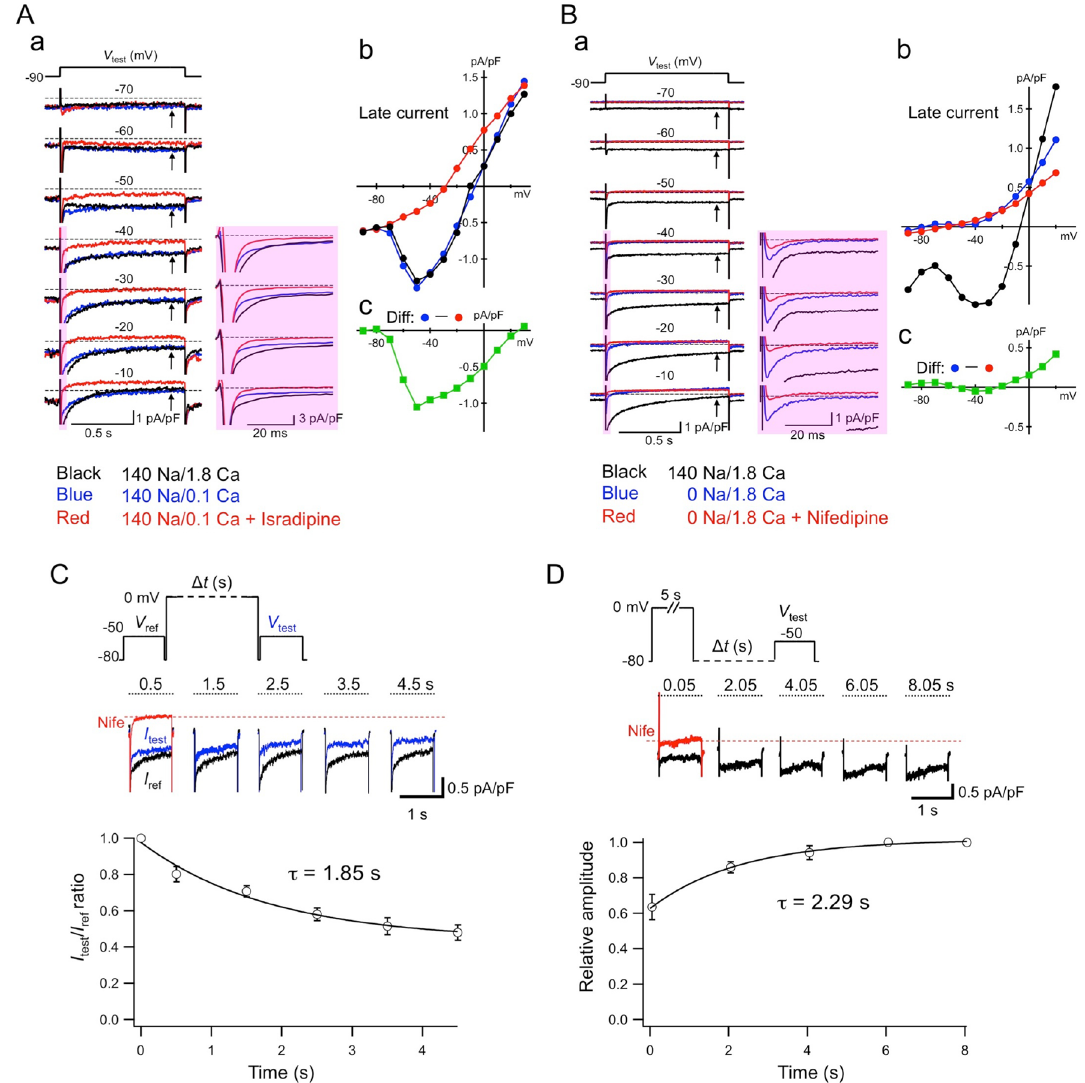
Figure 1. Presence of I st in mouse SAN cells. ( A ) (a) Superimposed whole-cell membrane currents recorded from the same cell in 1.8 mM [Ca 2 + ] o (control, black ), in 0.1 mM [Ca 2 + ] o ( blue ) and after exposure to 1 µ M isradipine ( red ). Individual SAN cells were voltage clamped at a holding potential of − 90 mV and depolarized for 1 s to indicated test potentials in 10-mV increments. Peaks of transient inward currents at the beginning of test pulses are not to scale. The inset shows close-up views of the initial part ( red shaded area ) of current traces. ( b ) Corresponding isochronal I – V relationships of the late current measured at time points marked with arrows in a. (c) I – V relationship of the isradipine-sensitive current obtained by subtraction of the current recorded after application of isradipine from that recorded in 0.1 mM [Ca 2 + ] o . ( B ) (a) Superimposed whole-cell membrane currents recorded in the same cell in 1.8 mM [Ca 2 + ] o (control, black ), in NMDG-substituted, Na + -free solution ( blue ) and after exposure to 1 µ M nifedipine ( red ) using the same pulse protocol as in ( A ). The inset shows close-up views of the initial part ( red shaded area ) of current traces. (b) Corresponding I – V relationships of the late currents from the recording depicted in a. (c) I – V relationship of the nifedipine-sensitive current obtained by subtraction of currents after application of nifedipine from recordings in the NMDG-substituted, Na + -free solution. ( C ) Time dependency of the sustained inward current inactivation measured using a protocol ( upper panel ) consisting of a reference test pulse ( V ref ), a conditioning prepulse of various durations, and a subsequent test pulse ( V test ). Sample traces of I ref ( black ) and I test ( blue ) recorded in response to V ref and V test , respectively, in 0.1 mM [Ca 2 + ] o were superimposed. The red trace (Nife) was recorded in the presence of 1 µ M nifedipine and indicates the background level at − 50 mV ( red dash line ). The dotted line ( black ) indicates the zero-current level. The bottom panel shows a plot of the average ratio of I test / I ref as a function of the conditioning pulse duration. The continuous line represents a single exponential fit. ( D ) Time dependency of the recovery from inactivation of the sustained inward current measured using a double-pulse protocol ( upper panel ) with varying recovery intervals (0.05–8.05 s) at − 80 mV between a 5-s conditioning prepulse to 0 mV and a test pulse ( V test ) to − 50 mV. Current amplitudes are normalized to the largest current obtained with a recovery interval of 8.05 s. Sample traces and panels are labelled as in ( C